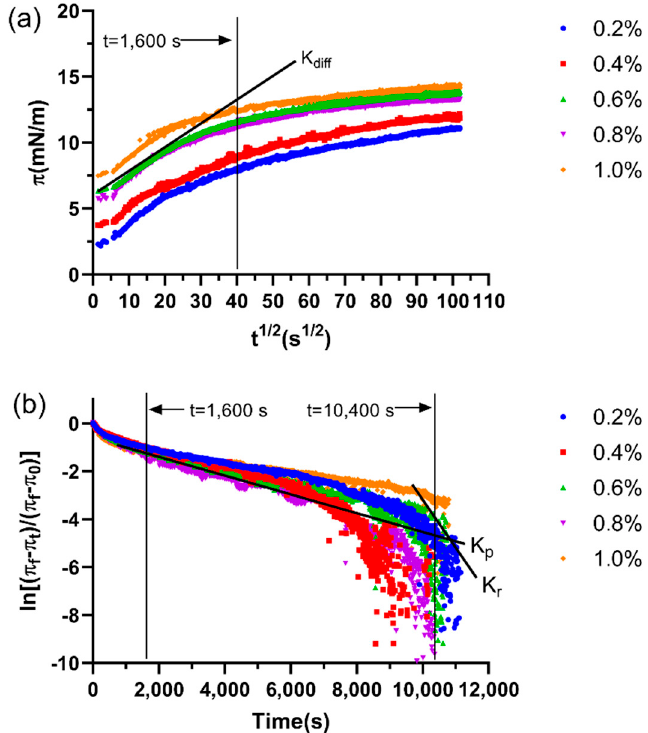
Figure 5. The square root of time (t 1/2 ) dependence of interfacial pressure ( π ) ( a ) and the profile of the molecular penetration and configurational rearrangement steps ( b ) for LSEP at the MCT-water interface. K diff represents the diffusion rate, K p